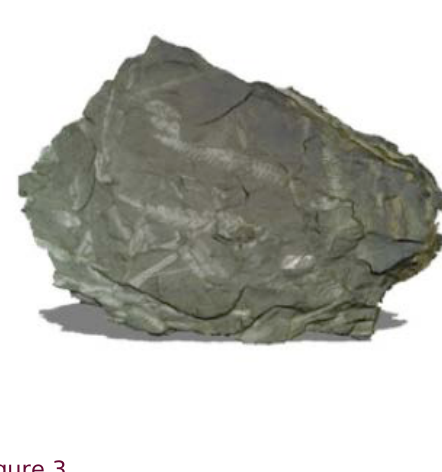
Fossilized fern scan converted to JPEG